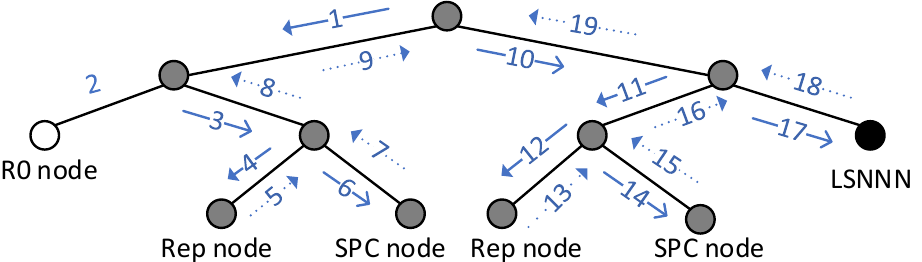
Figure 10. Schematic diagram of the decoding process based on traditional subcodes combined with LSNNN.